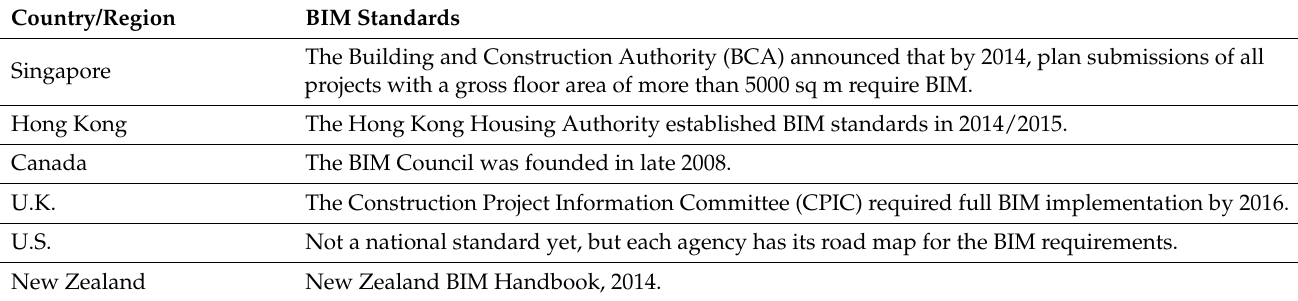
Table 1. BIM Standards by